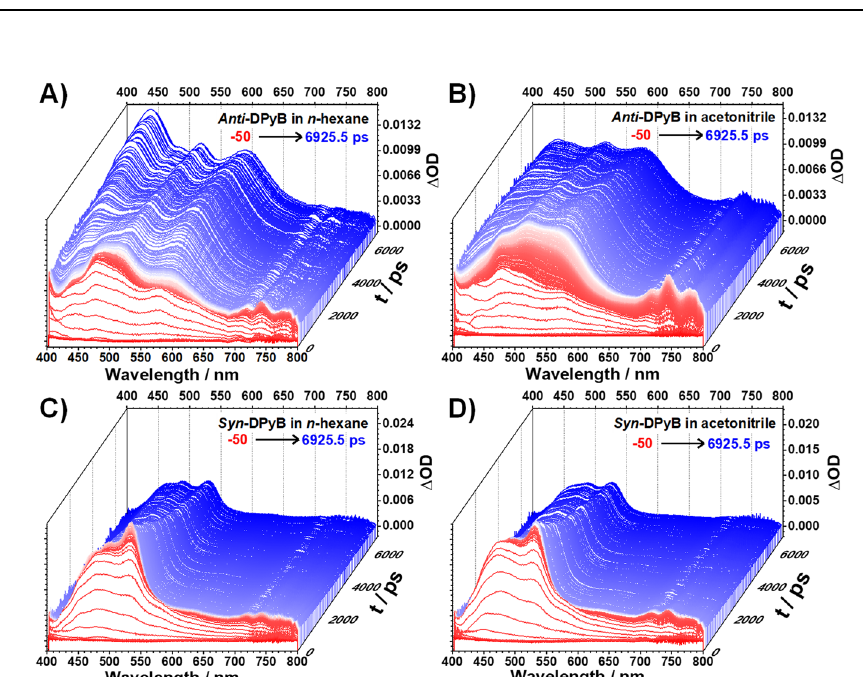
Fig. 3 Transient absorption spectra. A , B Transient absorption spectra of Anti -DPyB in n -hexane and acetonitrile, respectively. C , D Transient absorption spectra of Syn -DPyB in n -hexane and acetonitrile,